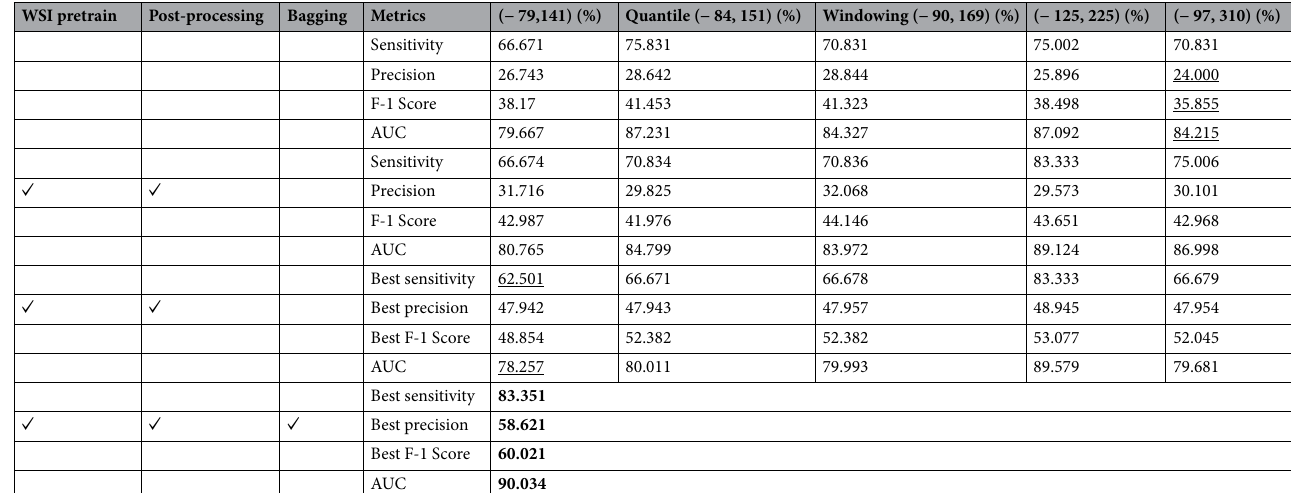
Table 4. Performance comparison and ablation studies on the test set of 68 Ga-PSMA-11 PET/CT. Bold results are the best ones. Underlined results are the worst cases, indicating the effectiveness of ablated strategies. Sensitivity, Precision, F-1 score, and area under the curve (AUC) are used as evaluation metrics. Specifically, AUC is calculated image-based, where the probabilities of any detected nodes for an image will be examined, and the maximum of those nodules will be chosen as an image score, and if there is no prediction for a certain image, we set the corresponding image score as 0. Results in the last three rows are generated from “window bagging” of the model predictions of all quantile windowing ranges listed in the below